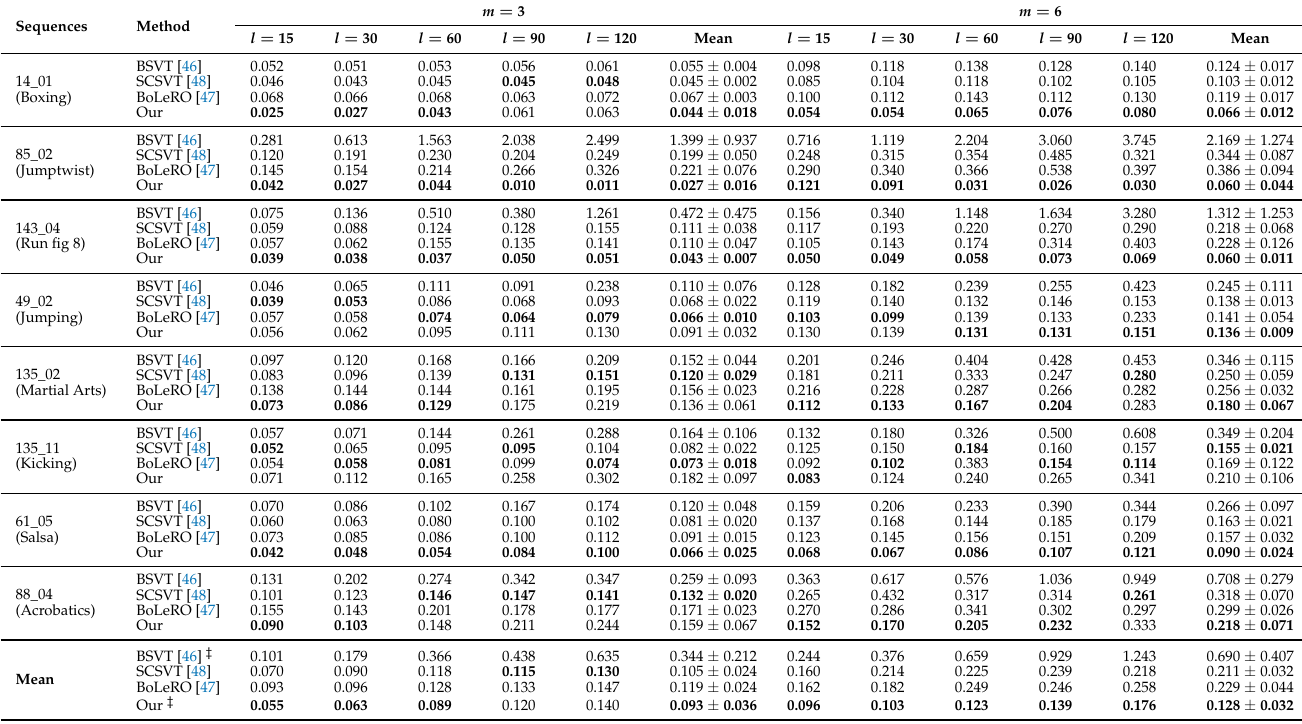
Table 1. Comparison with other state-of-the-art methods in terms of RMSE of the recovered Mo- Cap